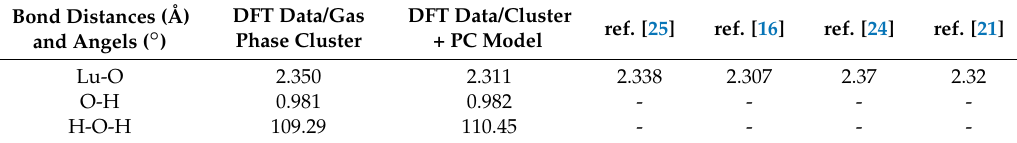
Figure 1. Left : Structure of the octaaqua Lu 3+ - ion (symmetry S 8 ) as a gas phase cluster and imbedded in a polarizable dielectric continuum simulating the bulk water. At the right : The LuO 8 skeleton (H 2 O as point masses) with its D 4d symmetry. Table 1. Geometrical parameters such as bond distances and angles of [Lu(H 2 O) 8 ] 3+ imbedded in a polarizable dielectric continuum. Comparison of our DFT results (B3LYP/LANL2DZ) with published MD simulation and experimental results.